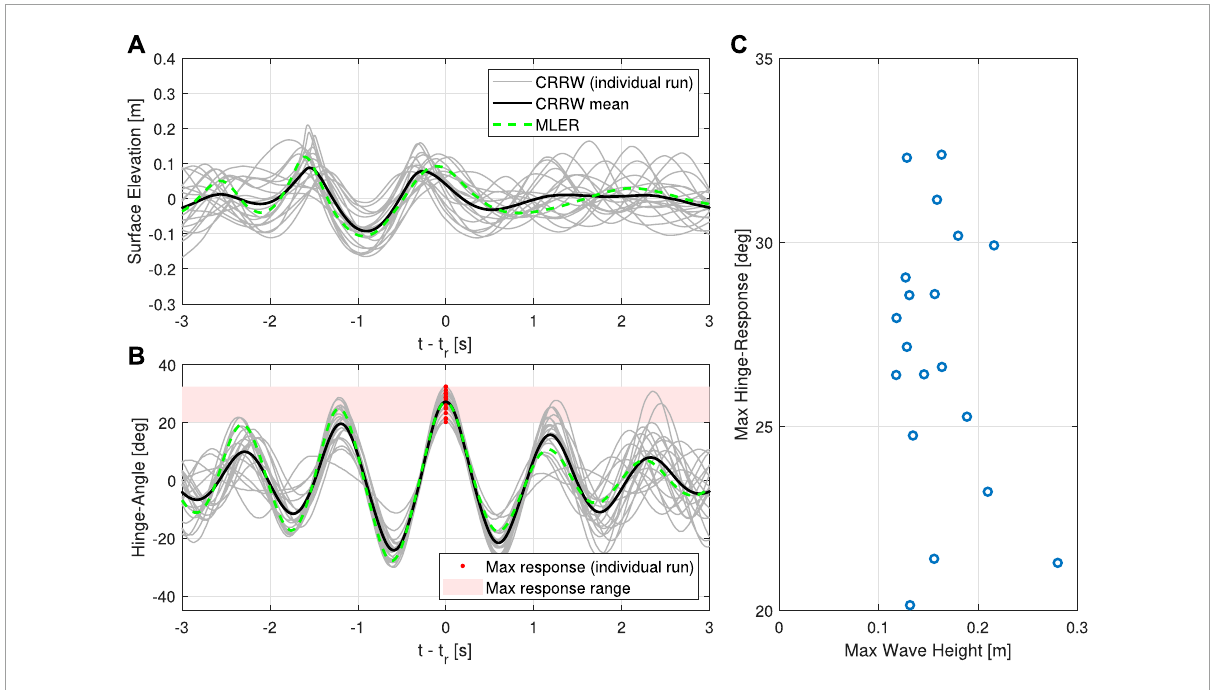
FIGURE 8 Surface elevation (A) and hinge-angle (B) time series for the CRRWs around the time of maximum response ( t r ) for the 50-year sea state ( γ = 3 . 3 ) . Each grey line is a single CRRW run and the mean profile is given by the black solid line, with the corresponding MLER provided for reference (green dashed). The maximum hinge-angle achieved for each run is indicated by the red dots, along with the range of these responses (red shaded region). Variation of maximum hinge angle response with maximum wave height is also shown (C)